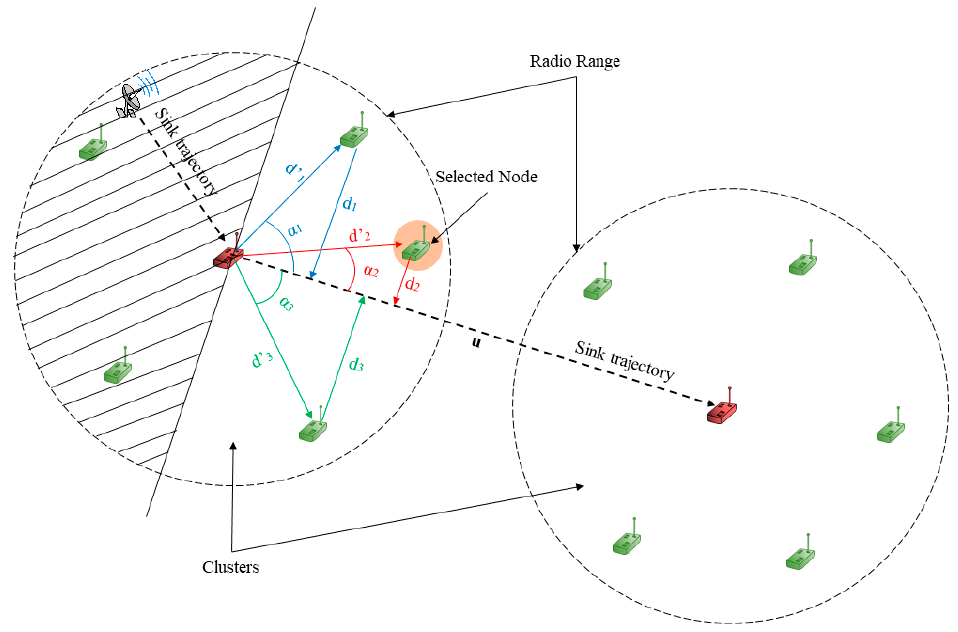
Figure 6. Selecting the closest CM to the trajectory of the sink.